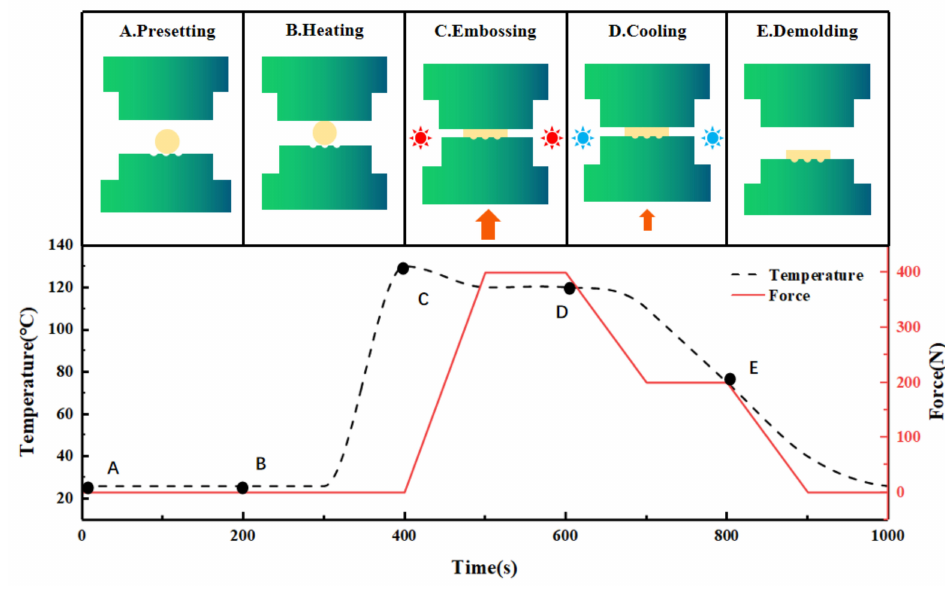
Figure 2. Process diagram of hot press forming and time history of force and temperature.